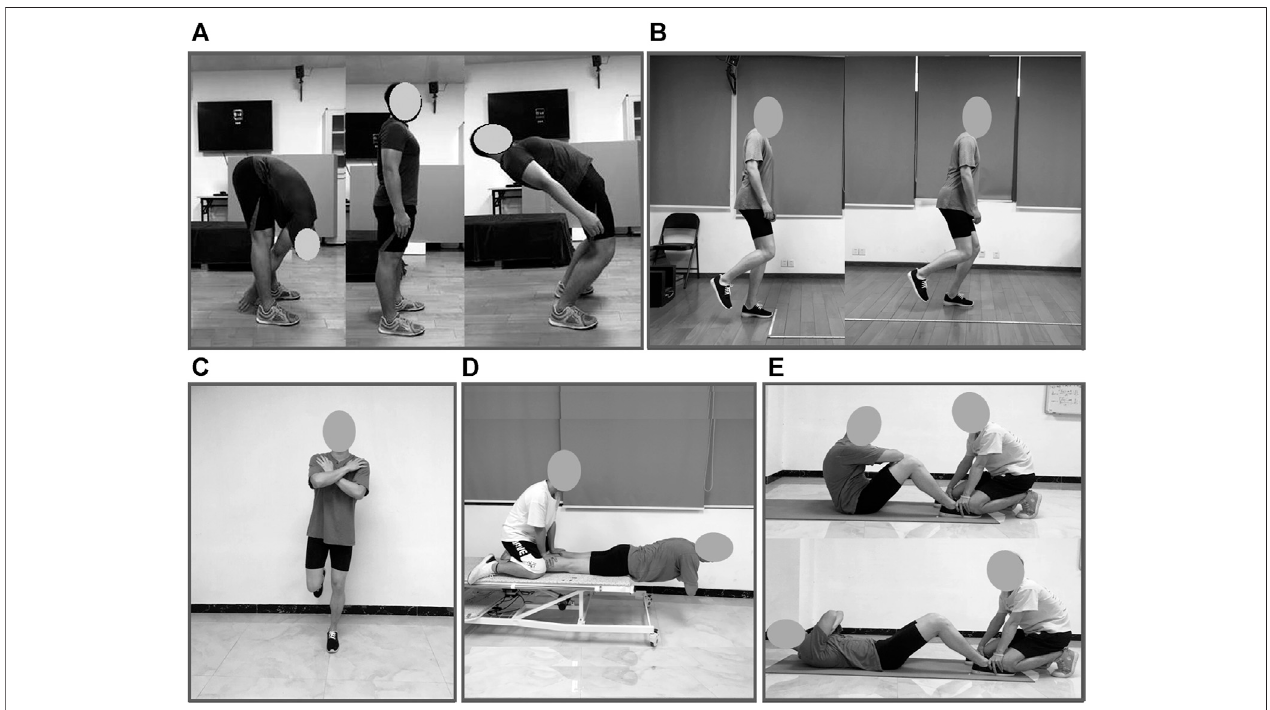
FIGURE 2 | Five core-related measurements. (A) . From left to right: trunk fl exion (TF), neutral, and extension (TE) range of motion test, where trunk fl exion to extensionrangeofmotion(TFE)wasrecordedasthesumofTFandTE. (B) .Dominantlimbsingle-leghopdistance(DLH)test. (C) .Dominantlimbsingle-legstance(DLS) test. (D) . Trunk extensor endurance (EE) test, and (E) . Sit-ups in 20 s (SU)